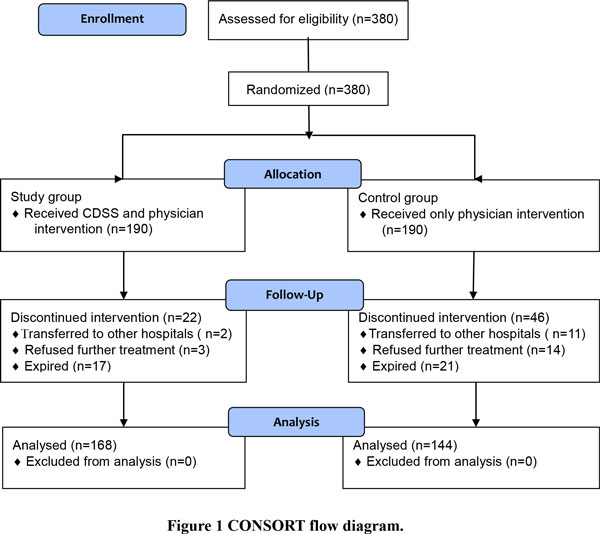
CONSORT flow diagram.